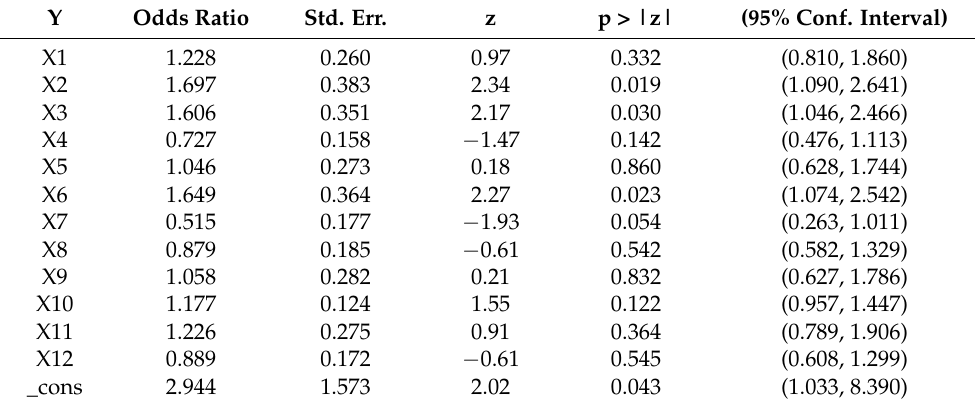
Table A2. The first step of stepwise logistic regression.